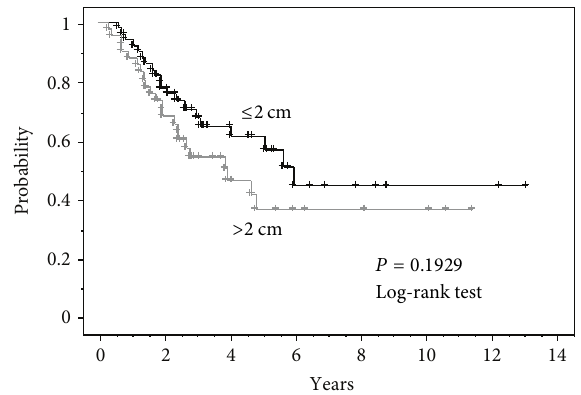
Figure 4: Cause specific survival for tumor diameter ≤ 2 cm ( 𝑛 = 50 ) versus > 2cm ( 𝑛 = 41 ) 3y. Cause specific survival rate ≤ 2cm: 70.6%, > 2cm: